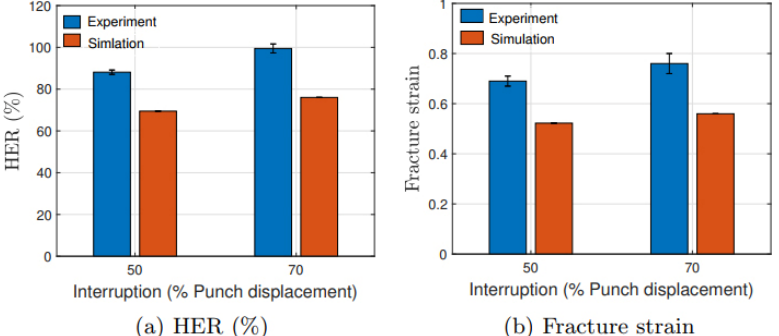
Fig. 16 Comparison of experimental and simulated (a) HER values and (b) fracture strains for interrupted loading conditions. Reproduced with permission from Ref. [9], © CIRP